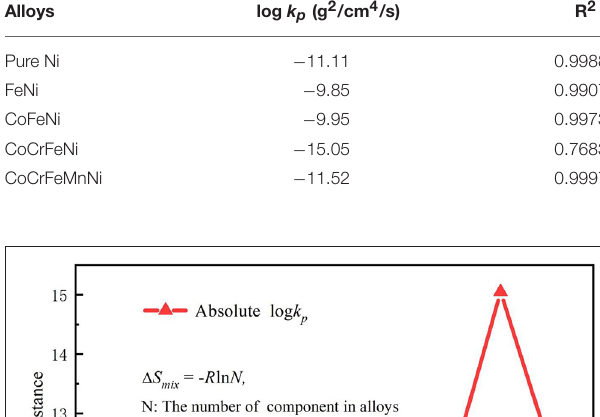
FIGURE 2 | Weight gain per unit surface area ( 1 W / A ) as a function of oxidation time for pure Ni and other studied alloys after isothermal oxidation testing at 800 ◦ C for 150min.